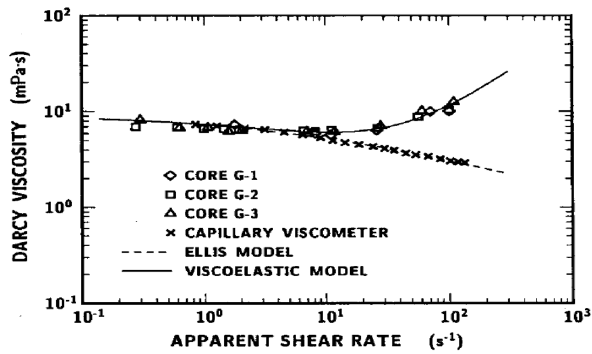
Fig. 9 Viscosity versus shear rate for 200 ppm polyacrylamide (from Masuda et al.